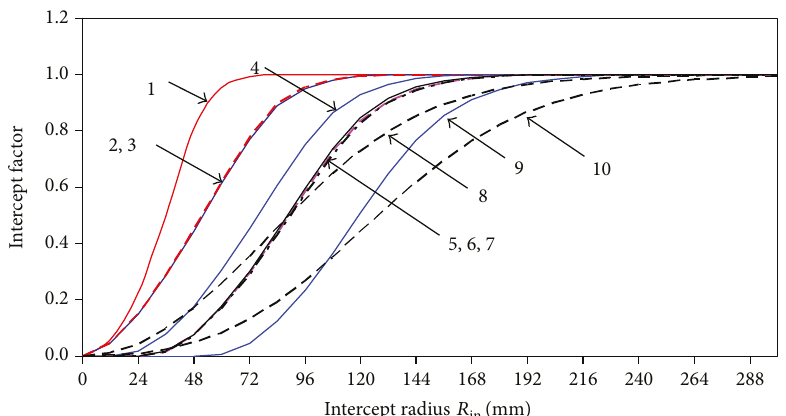
Figure 10: In fl uence of the EATD tracking error and mirror slope error on the intercept factor. 1: w =0; 2: β =0 ° , ε =3.6, ε =0, w =3.6; err 1 2 err 3: β =0 ° , ε =3, ε =2, w =3.6; 4: β =0 ° , ε =6, ε =0; 5: β =30 ° , ε =2, ε =8, w =7.184; 6: β =0 ° , ε =3.95, ε =6, w =7.184; 7: β =0 ° , 1 2 err 1 2 1 2 err 1 2 err ε =7.184, ε =0; 8: β =0 ° , ε =6, ε =0, σ =2; 9: β =0 ° , ε =10, ε =0; 10: β =0 ° , ε =10, ε =0, σ =2. Note: only curve 10 and 14 have the 1 2 1 2 1 2 1 2 mirror slope error of σ = 2mrad , other curves have the mirror slope error of σ = 0mrad.